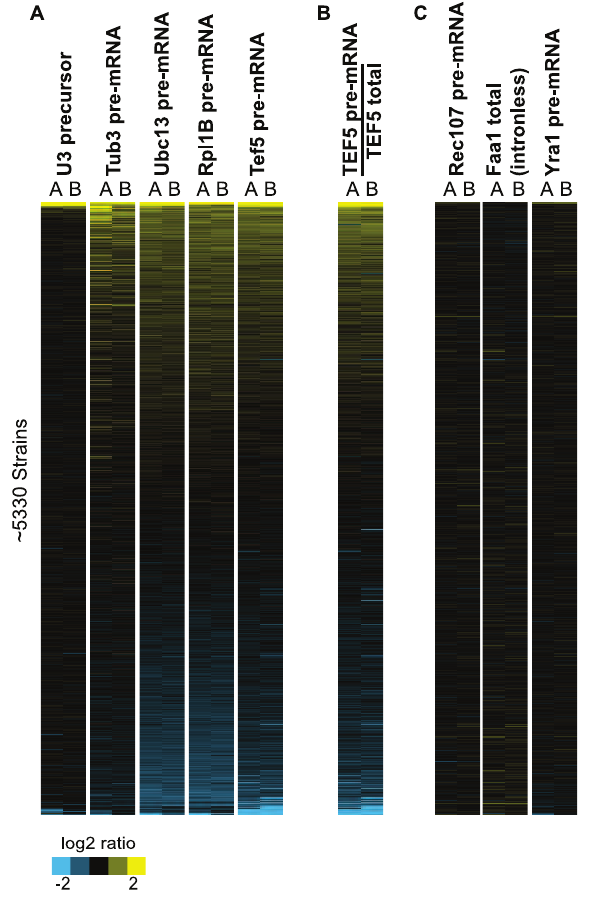
Figure 4. Increases in precursor levels correlate with a decrease in splicing efficiency. A. Relative levels of the indicated RNAs are shown in the background of 5334 strains. The data are ordered from high to low values based on a composite rank order, determined on the basis of the expression levels of the five canonical splicing substrates. B. The relative splicing efficiency of the Tef5 transcript in each of these strains, calculated as the relative Tef5 precursor levels divided by the relative Tef5 total RNA levels. C. The relative levels of the low abundance Rec107 pre–mRNA and Faa1 transcripts are shown along with the inefficiently spliced Yra1 pre–mRNA, none of which shows a similar pattern to the splicing defects seen in (A).